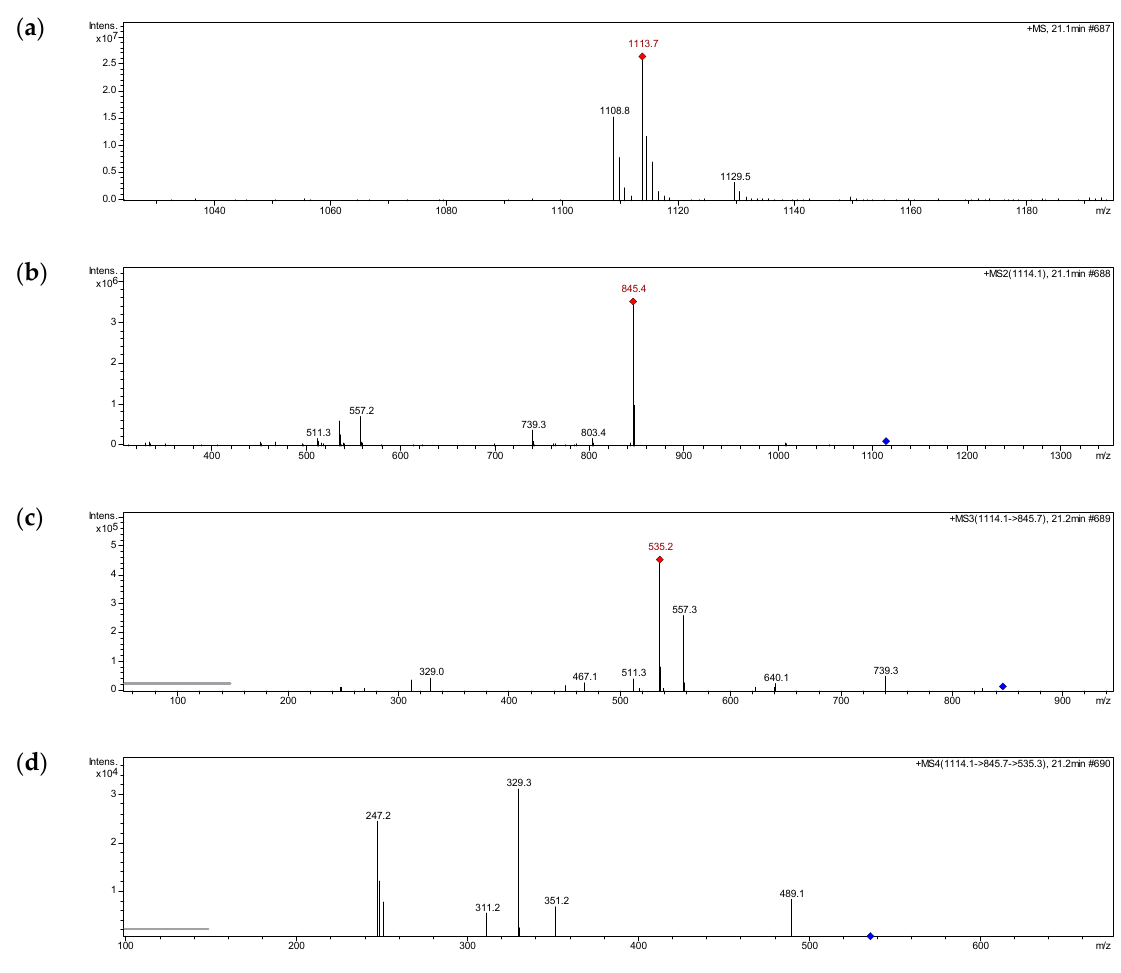
Figure 5. MS n spectra of A8. ( a ) Full-scan MS 1 spectrum, ( b ) ESI-MS 2 spectrum, ( c ) ESI-MS 3 spectrum, ( d ) ESI-MS 4 spectrum.